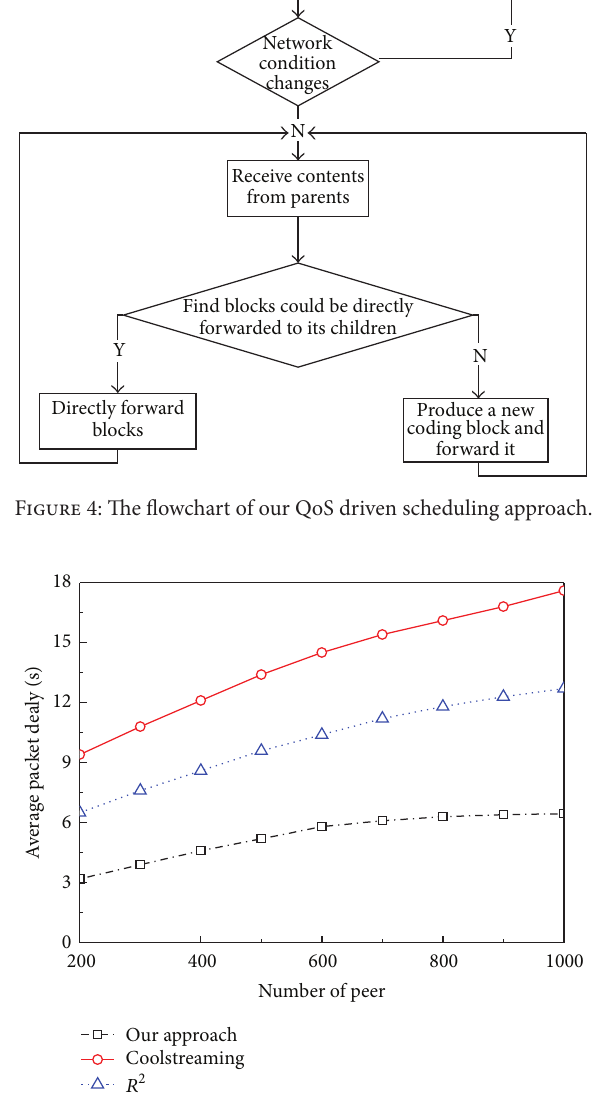
Figure 5: Average packet delay versus number of